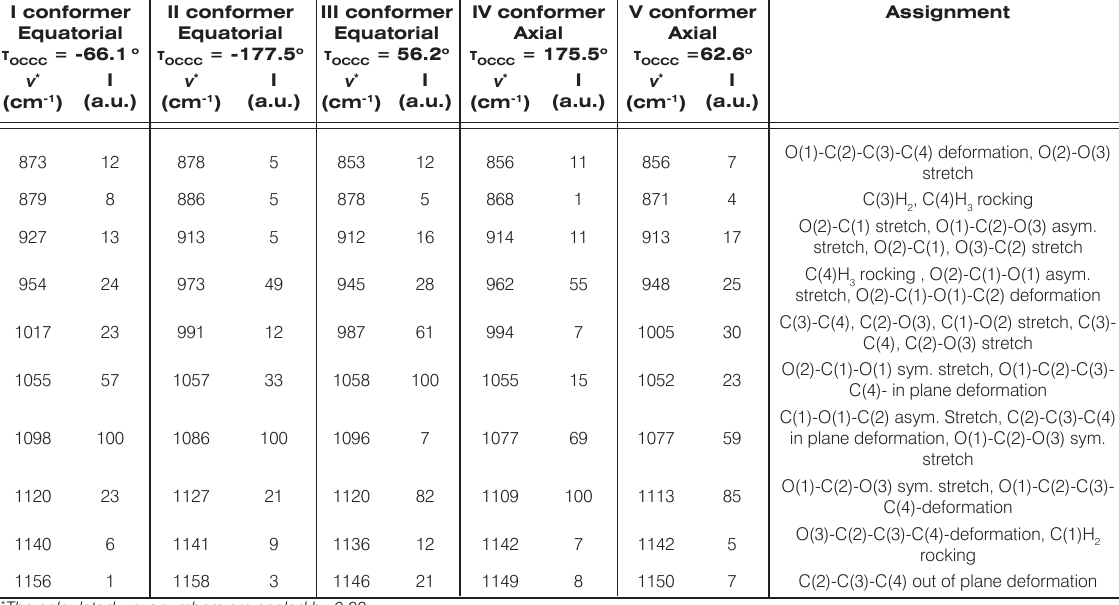
Table 2. DFT calculated (B3LYP\6-311++G(3df, 3pd)) normal vibrations of five most stable 1-butene SOZ conformers in the spectral region of the five membered ring